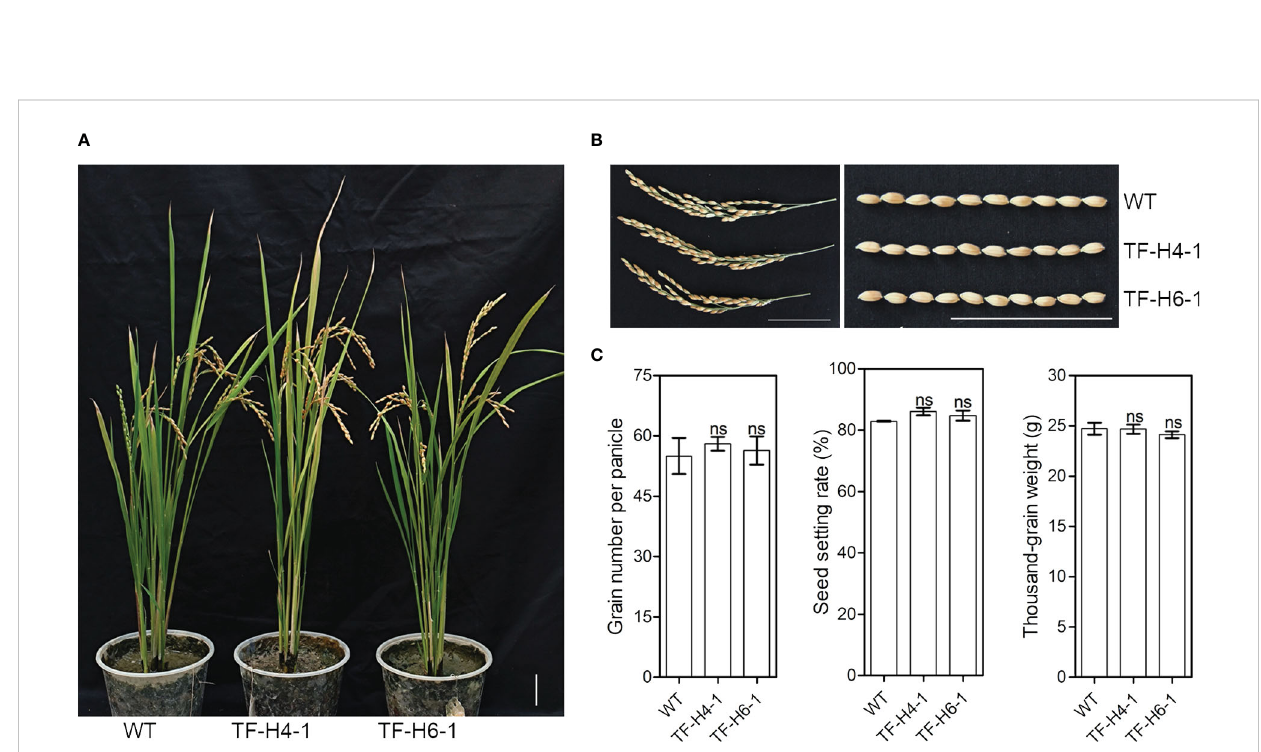
FIGURE 6 The major agronomic traits of ‘ transgene-free ’ OsHPP04 knockout rice at mature stage. (A) The morphological phenotypes of rice. (B) Panicle and seeds. (C) The grain number per panicle, seed setting rate and thousand-grain weight. Data were analyzed by a two-tailed Student ’ s t-test (ns P > 0.05. Values are mean ± SE ). WT: wild-type rice. TF-H4-1 and TF-H6-1: two ‘ transgene-free ’ OsHPP04 mutant lines. Bars = 5